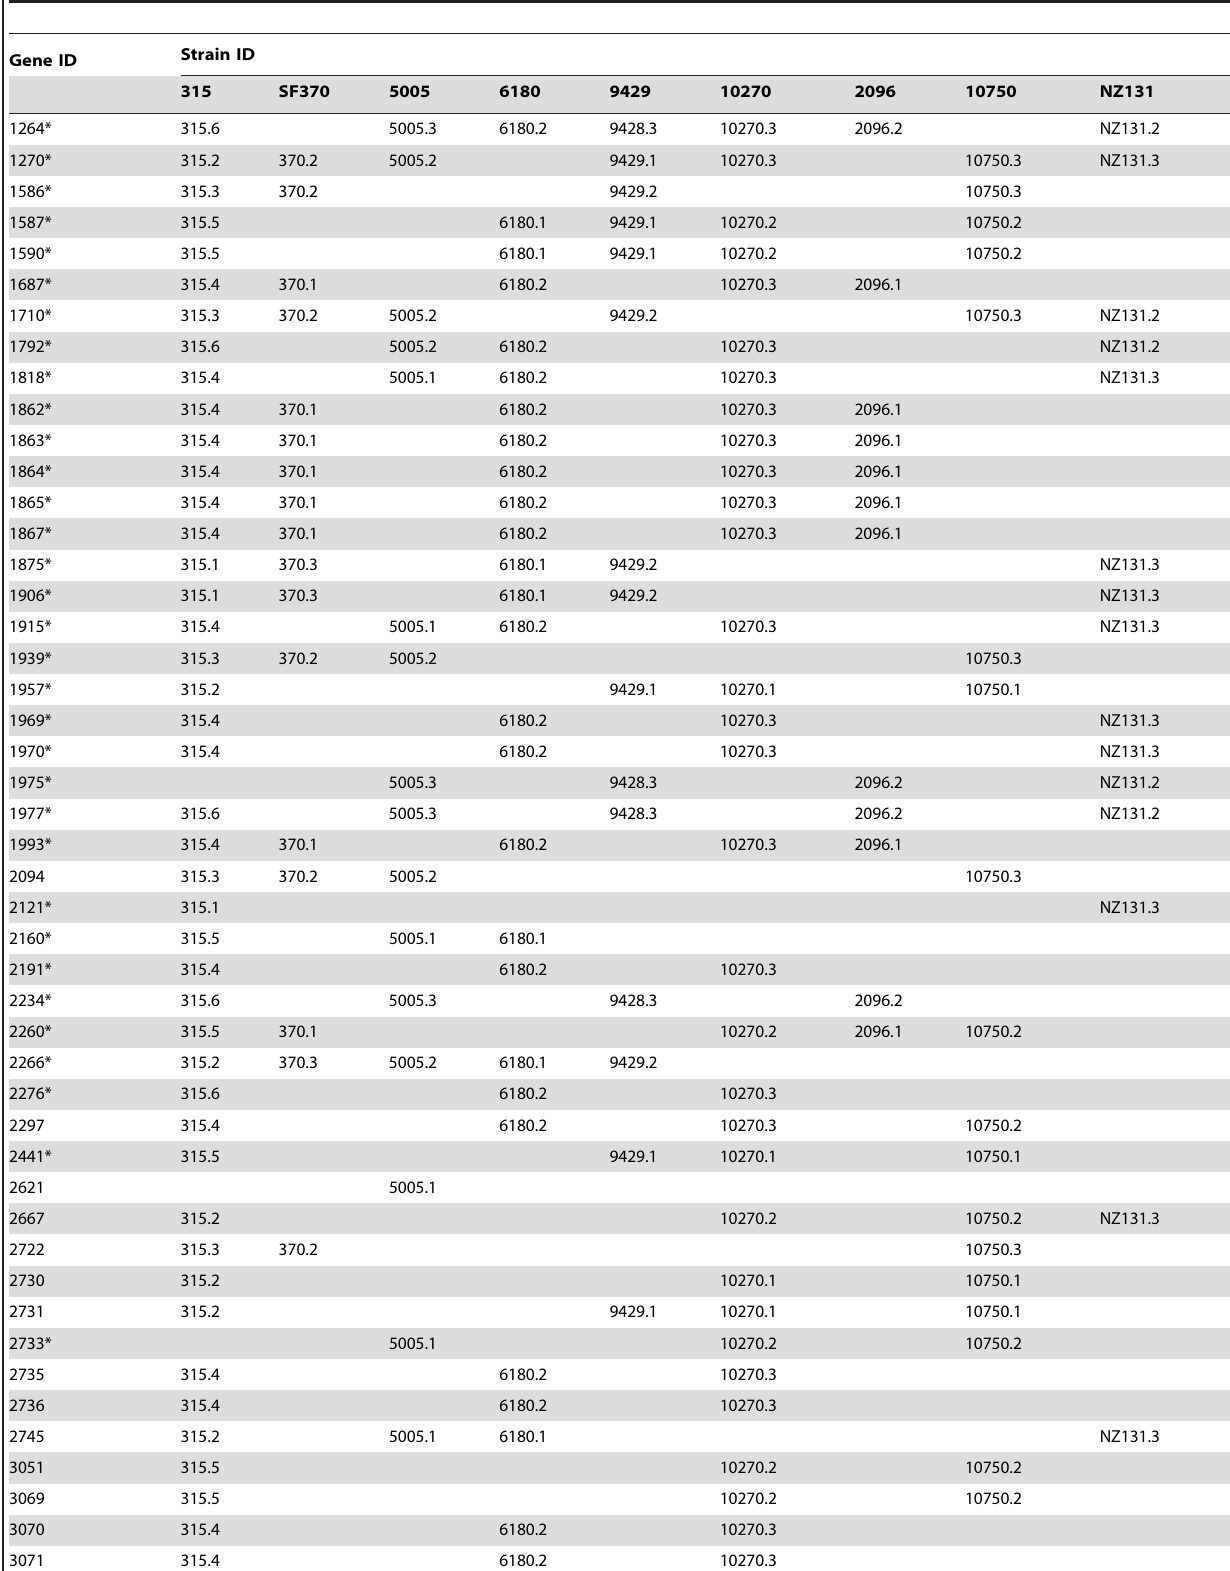
Table 4. Distribution of 52 phage genes gained on the S. pyogenes branch for nine strains that possessed phage descriptions in their